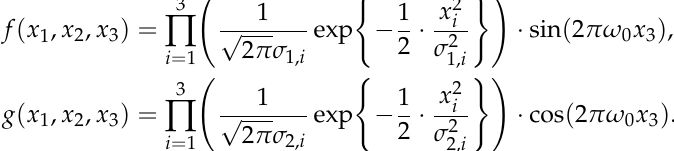
Figure 6. Slices for the volumetric data W R = ( − 0.95, + 1, − 1.05 ) , σ µ 2